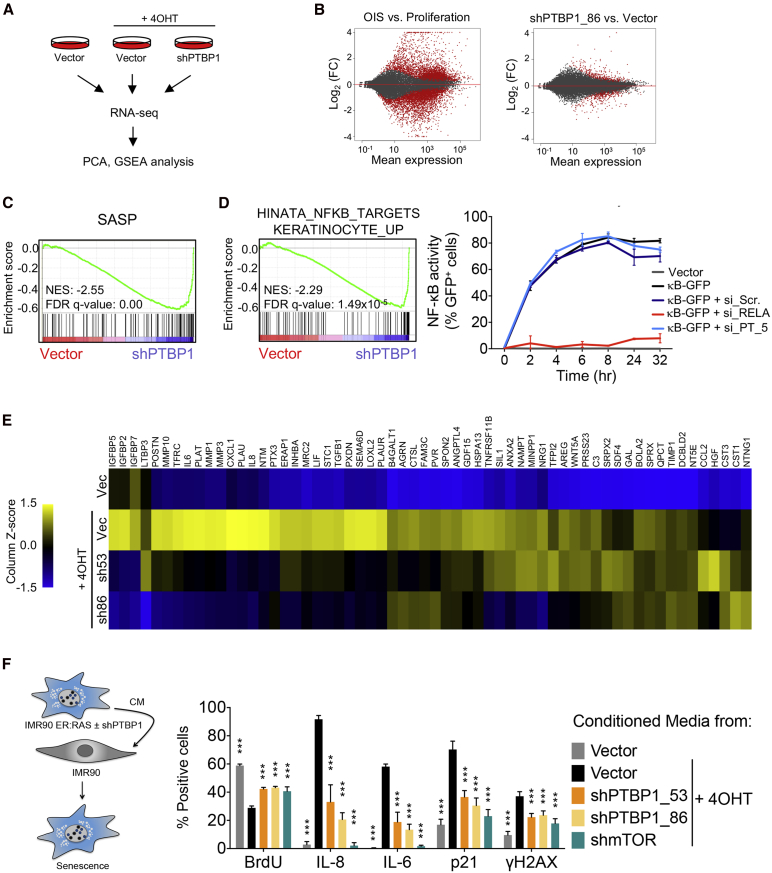
PTBP1 Regulates a Pro-inflammatory Subset of the SASP and Its Paracrine Functions(A) Experimental design for the global transcriptional profiling of IMR90 ER:RAS cells (6 days after 4OHT induction) presented in (B) to (D).(B) Subset of senescence-specific transcripts affected by PTBP1 knockdown. Mean expression (average of the normalized read counts for 3 replicates) in relation to log2 (FC) for the indicated comparison. Significantly changing genes are highlighted in red.(C) SASP GSEA signature in PTBP1 depleted cells + 4OHT compared with cells expressing empty vector + 4OHT.(D) NF-κB GSEA signatures in PTBP1 depleted cells + 4OHT compared with cells expressing empty vector + 4OHT (left). GFP analysis at indicated time points following TNFα (50 ng/mL) treatment in IMR90 cells expressing a κB reporter (κB-GFP) and transfected with indicated siRNAs (right). Data represent mean ± SD (n = 3).(E) Mass spectrometry analysis of CM collected from IMR90 ER:RAS cells (empty vector or two PTBP1-targeting shRNAs) 6 days after senescence induction with 4OHT. Differential secretion of the listed SASP factors shown as mean (n = 3).(F) Experimental design to assess the effect of PTBP1 loss on secreted factors responsible for inducing paracrine senescence (left). IF analysis of the senescence markers in IMR90 cells treated for 3–4 days with CM from the indicated IMR90 ER:RAS cells. Data represent mean ± SD (n = 3); each replicate experiment corresponds to independent generation of CM. ∗∗∗p < 0.001. Comparisons with cells treated with CM from Vector + 4OHT, two-way ANOVA (Dunnett's test).See also Figure S4.